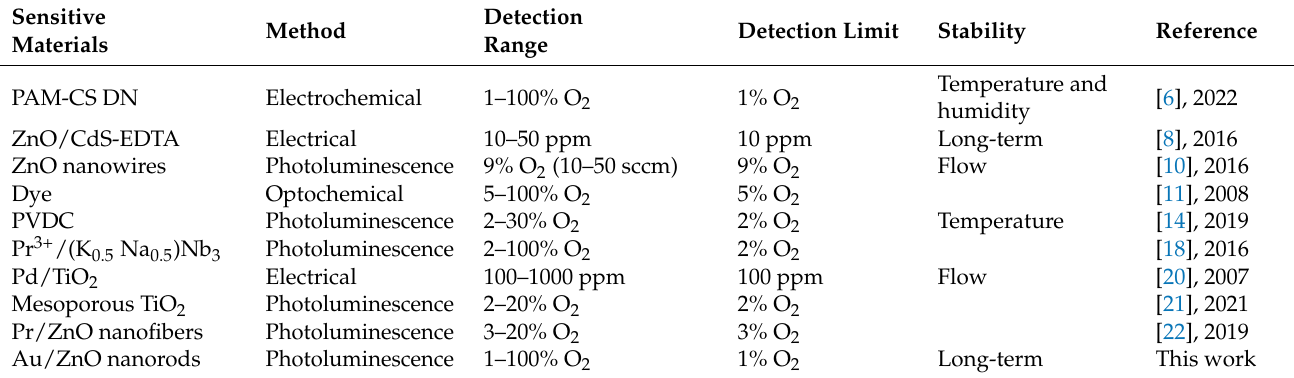
Table 1. Summary of the Sensing Properties of the O 2 Sensor.